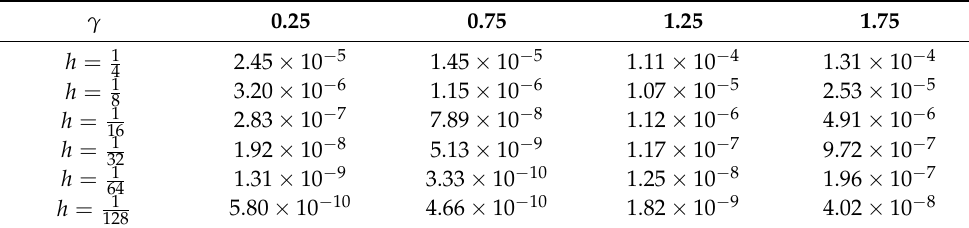
Table 5. Example 4: The infinity norm of the error (cid:107) e h (cid:107) for different values of γ and h .